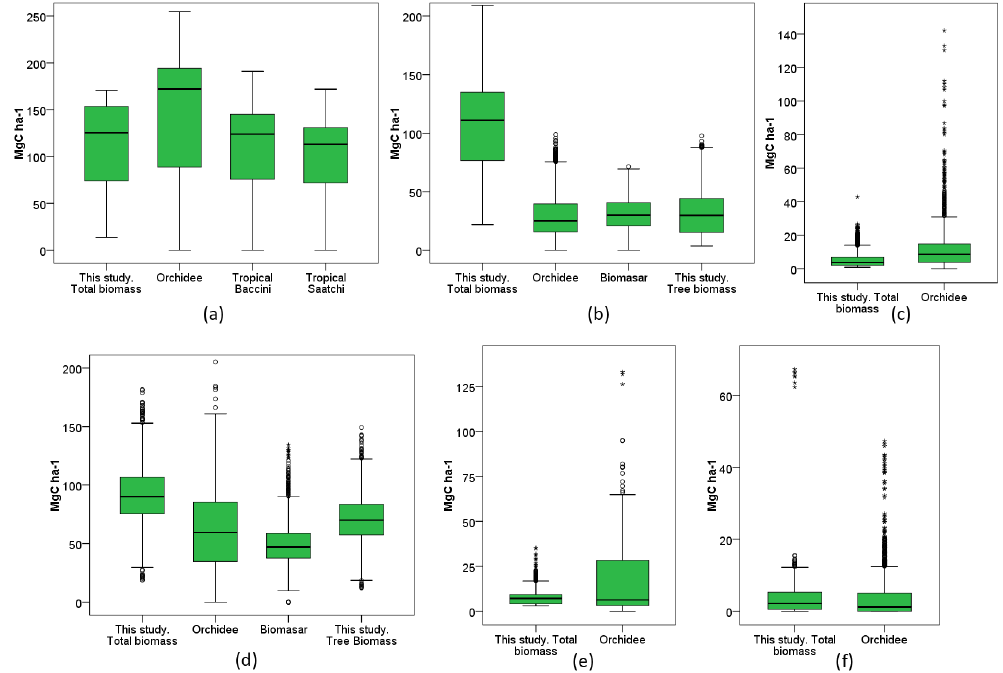
Figure 7. Box plots of the carbon biomass obtained for each product for the different land covers: (a) tropical forest, (b) boreal forest, (c) crops, (d) temperate forest, (e) savanna and shrub, and (f)